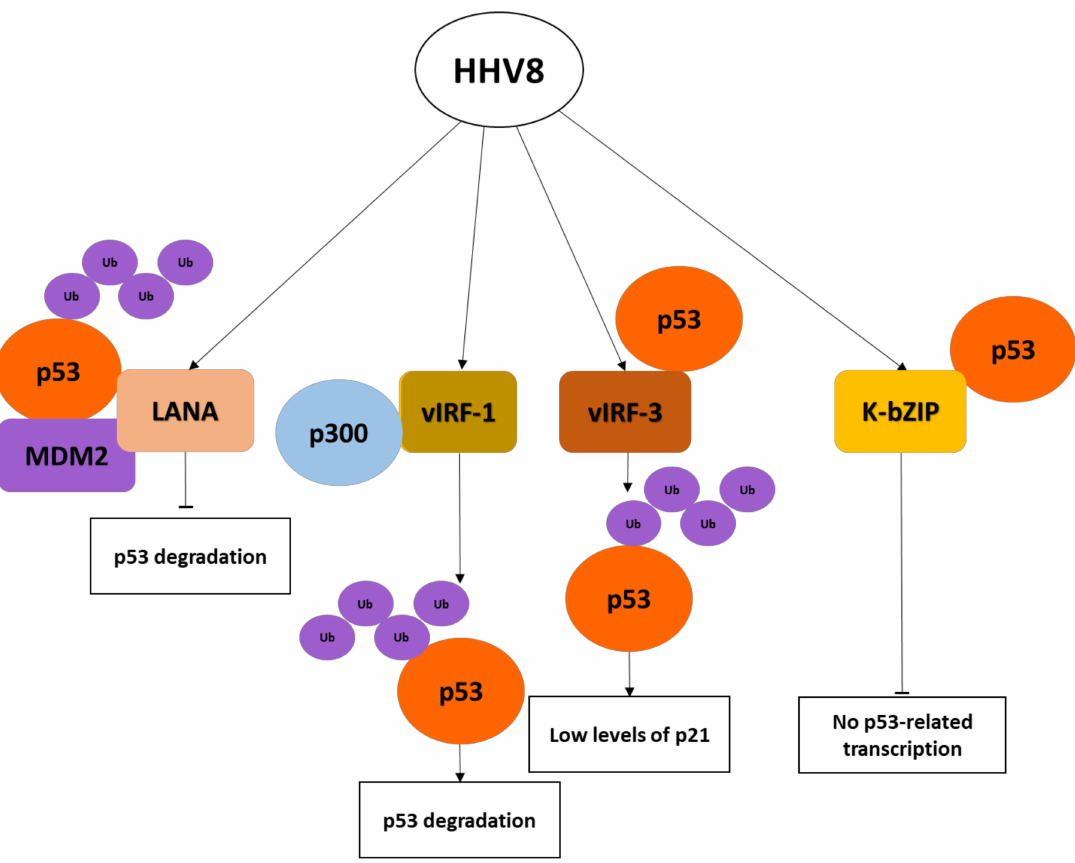
Figure 3. Schematic diagram of Kaposi’s sarcoma herpesvirus (HHV8) oncoproteins affecting p53 signaling pathways. K-bZIP, basic region–leucine